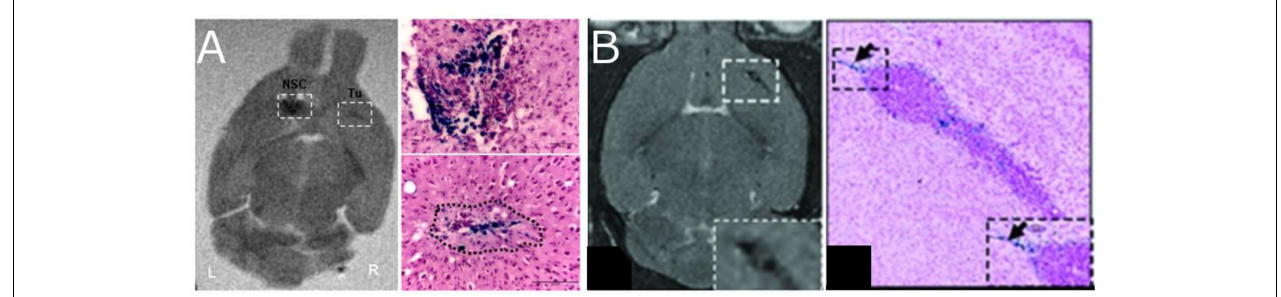
FIGURE 6 | Neural progenitor cells (NPCs) migrating to glioma after injection of SPIO labeled cells. The left two panels (A) show coronal ex vivo MRI images (T 2 -weighted) and Prussian Blue staining of tumor in animals with tumors 4 days after contralateral intracranial NPCs injection [Thu et al., 2009, reproduced via Plos One Creative Commons Attribution (CC BY) license]. Cells migrate away from the injection site and into the tumor. The right two panels (B) show in vivo MRI images (T 2 -weighted) and the Prussian blue histology of animals with IV injections of NPC (Gutova et al., 2013, reproduced with permission).